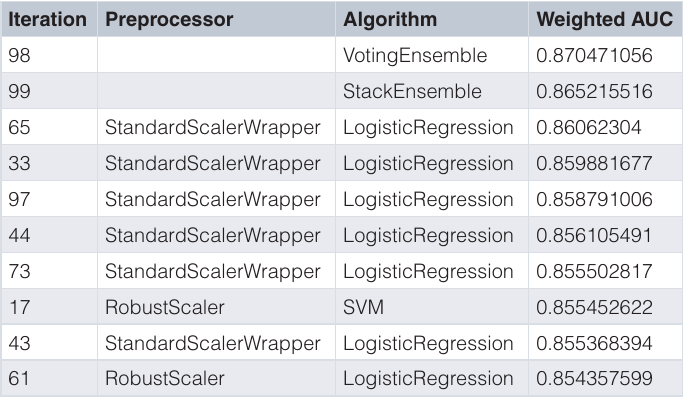
Table 10. Top 10 training iterations of the clearance rate model search. Note that the top performing model (VotingEnsemble) is the clearance rate model discussed in this paper.